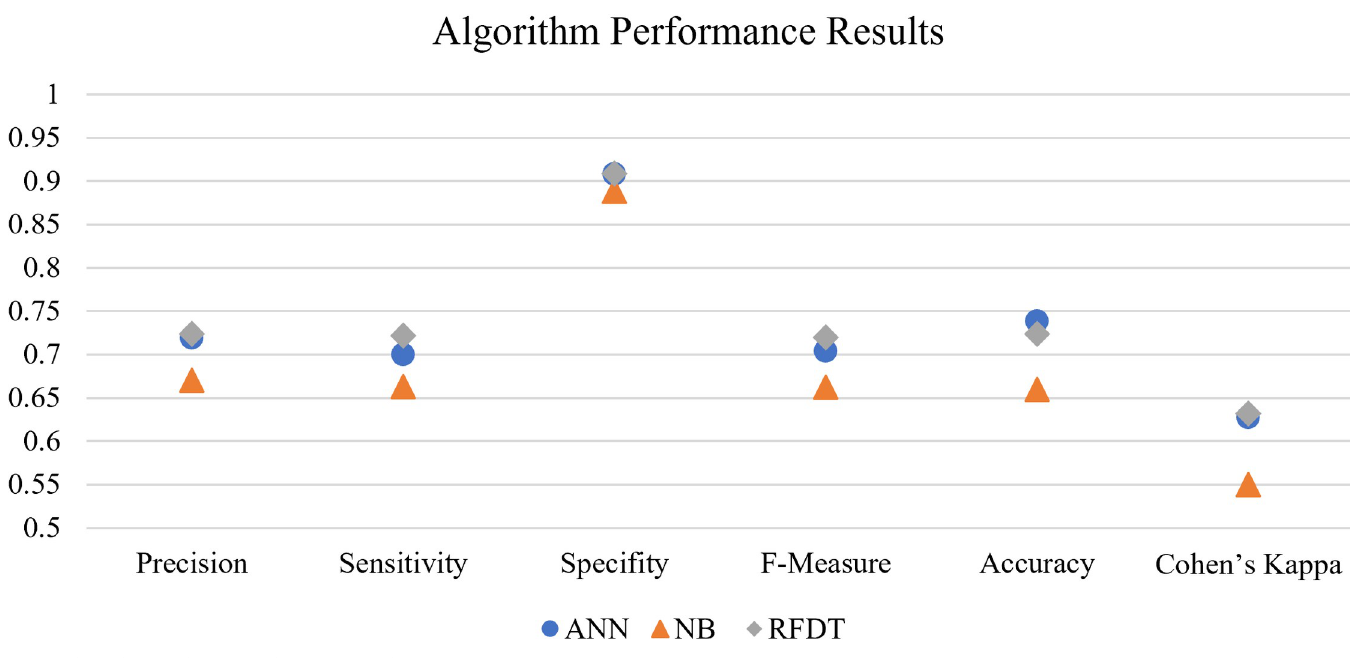
Fig 5. Algorithm prediction performance